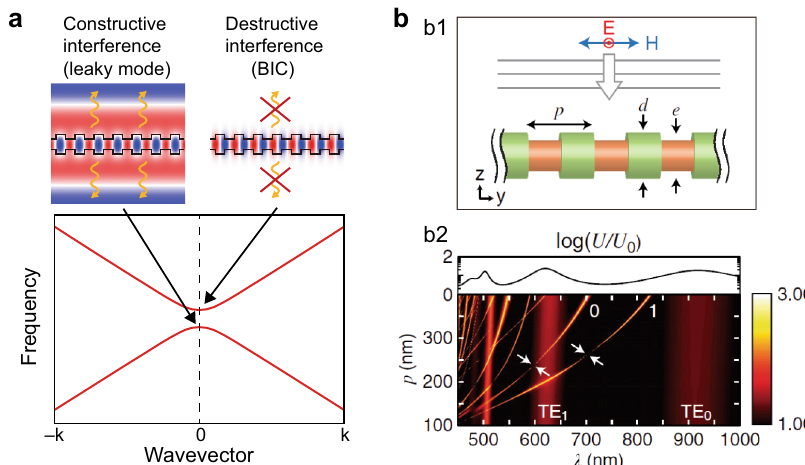
Fig. 2 Basic concept of BICs. a Calculated optical modes and band structure in a periodic waveguide. BIC modes with in fi nite radiative Q factors are formed by destructive interference. b Optical BICs in a nanowire geometric superlattice. Structure of a nanowire geometric superlattice (b1), and calculated map of the normalized energy on log scale, with varying pitch for fi xed nanowire diameters of 200 nm (outer) and 170 nm (inner) (b2). Reprinted by permission from ref. 21 , copyright